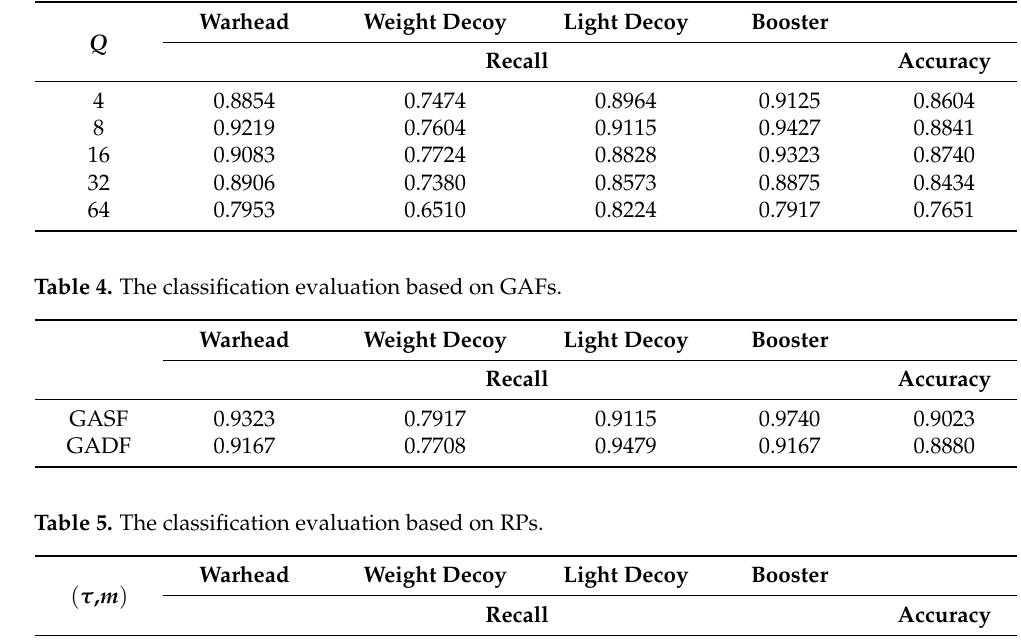
Table 3. The classification evaluation based on MTFs.